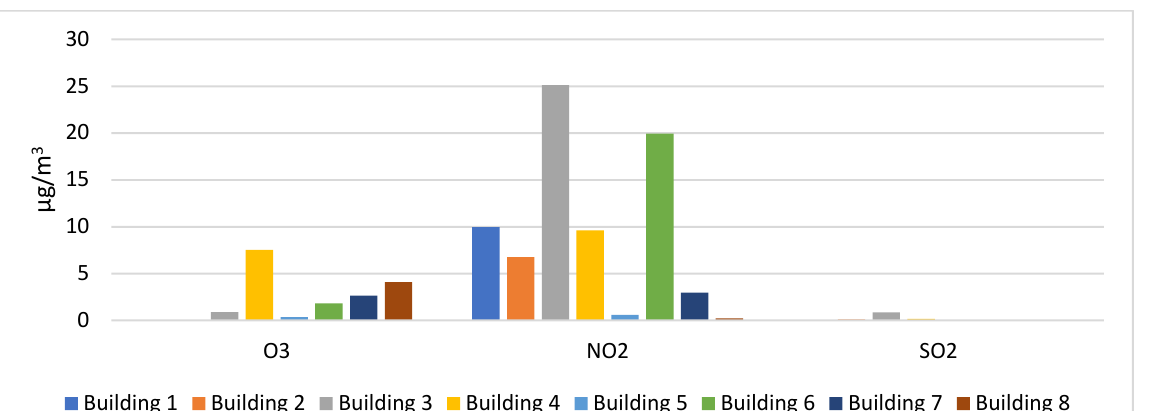
Figure 10. Indoor concentrations (μg m −3 ) of Aldehydes.